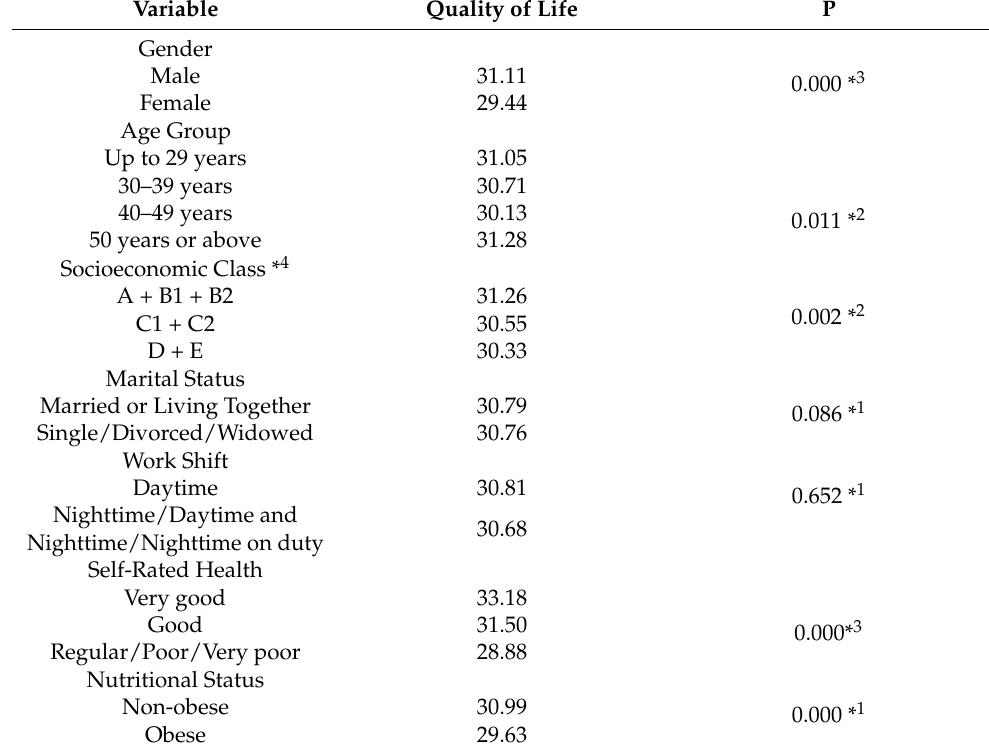
Table 2. Quality of life and demographic, socioeconomic, clinical, and behavioral characteristics of